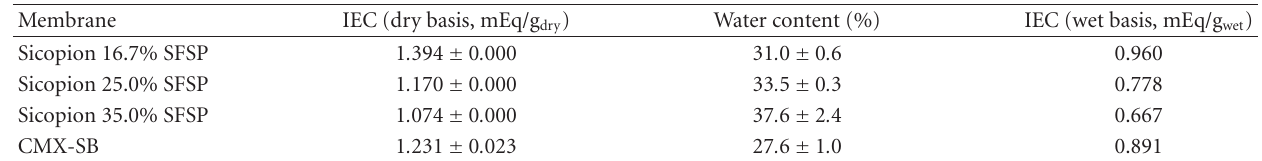
Table 1: Membrane ion-exchange capacity (IEC) (mEq/g ), water content (% of water on wet membrane basis), and IEC on wet dry membrane ). membrane basis (mEq/g wet membrane